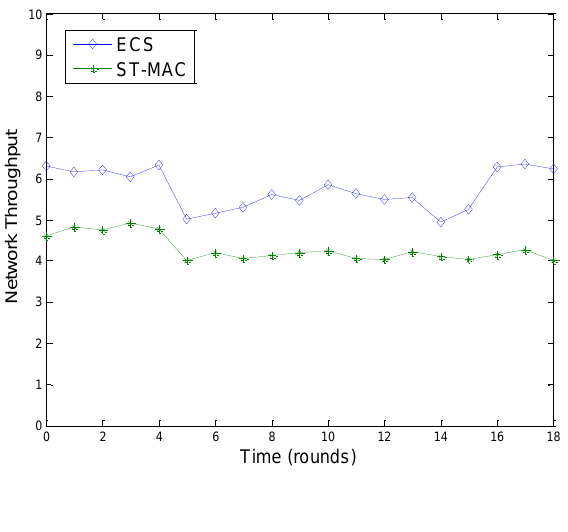
Figure 9. Efficiency of ECS in underwater harsh